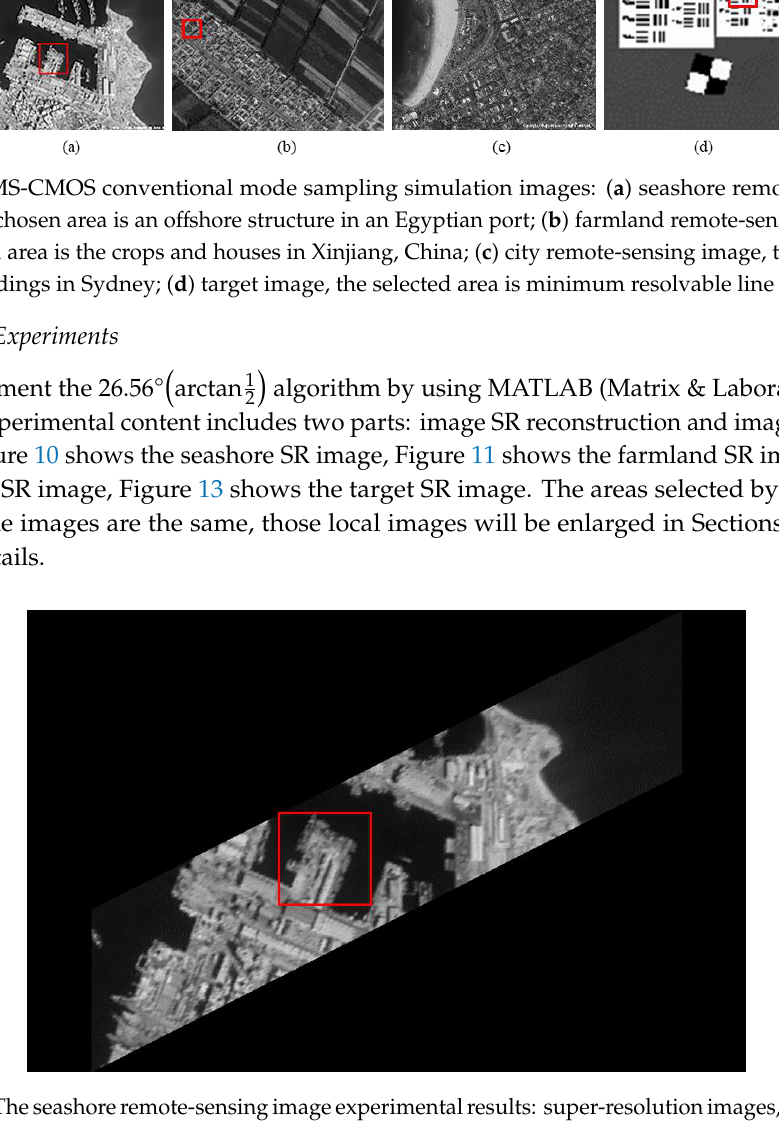
Figure 11. The farmland remote-sensing image experimental results: super-resolution images, the selected area is the crops and houses in Xinjiang, China.